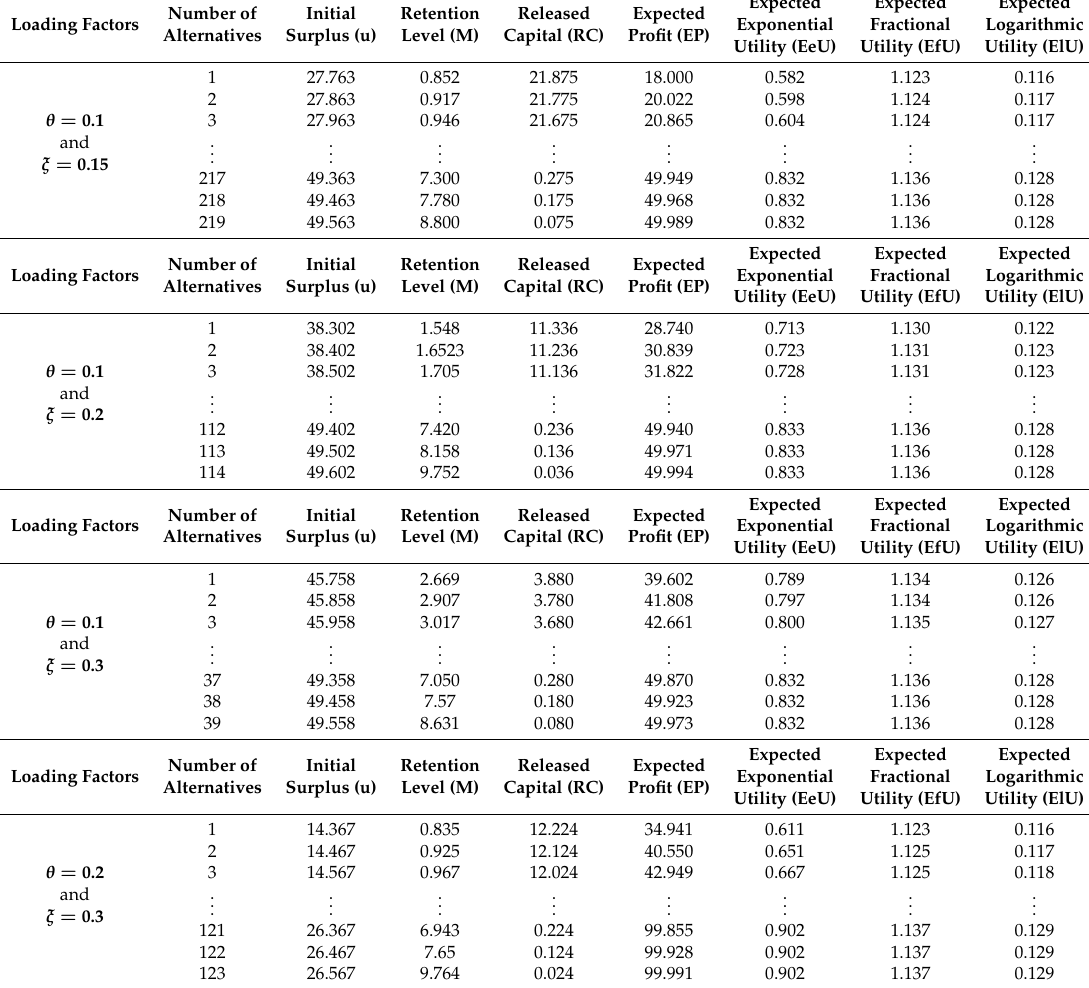
Table 6. Alternative sets for the exponential claims under the excess of loss reinsurance.